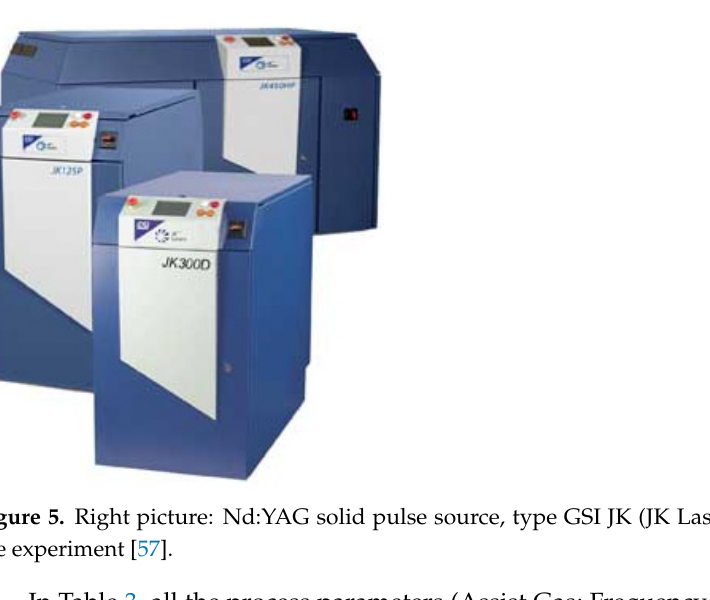
Table 3. Process parameters of laser beam drilling used on all applicable material thicknesses for both long and short cycles. Variable